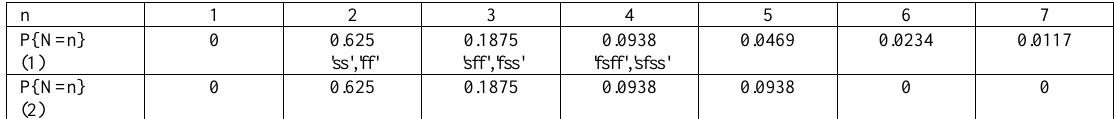
Table 5. P{N=n} for p 1 =0.75, p 2 =0.5: CSCF (k cs =k cf =2) (1), TSCSTFCF (k cs =k cf =2, k s =k f =3)